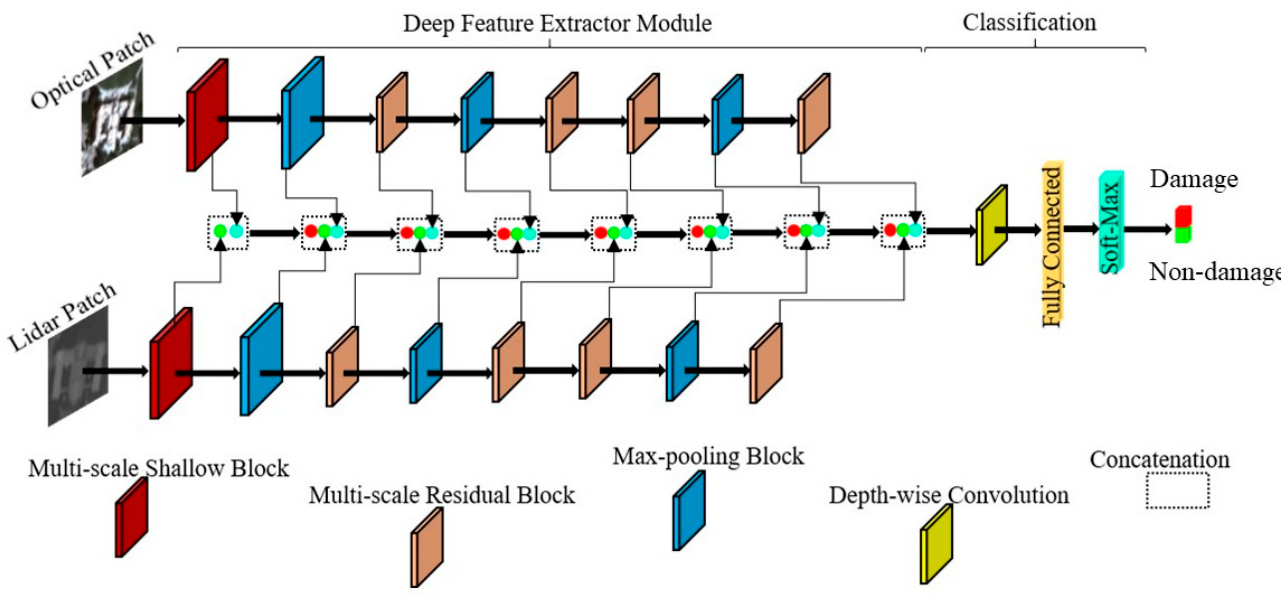
Figure 5. The proposed BDD-Net architecture for building damage detection.